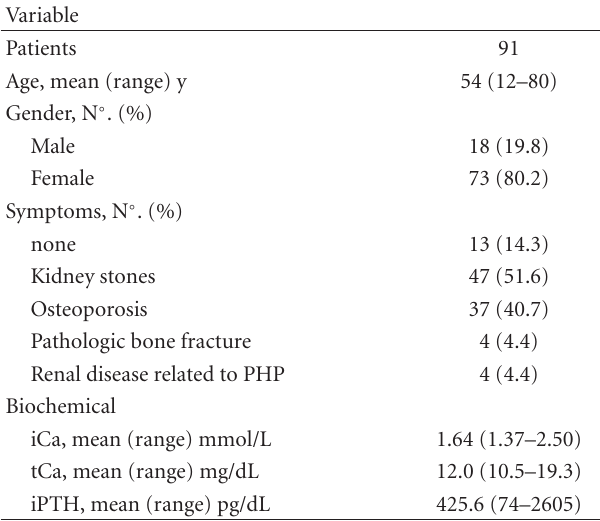
Table 1: Demographic, clinical, and biochemical aspects in 91 patients, with